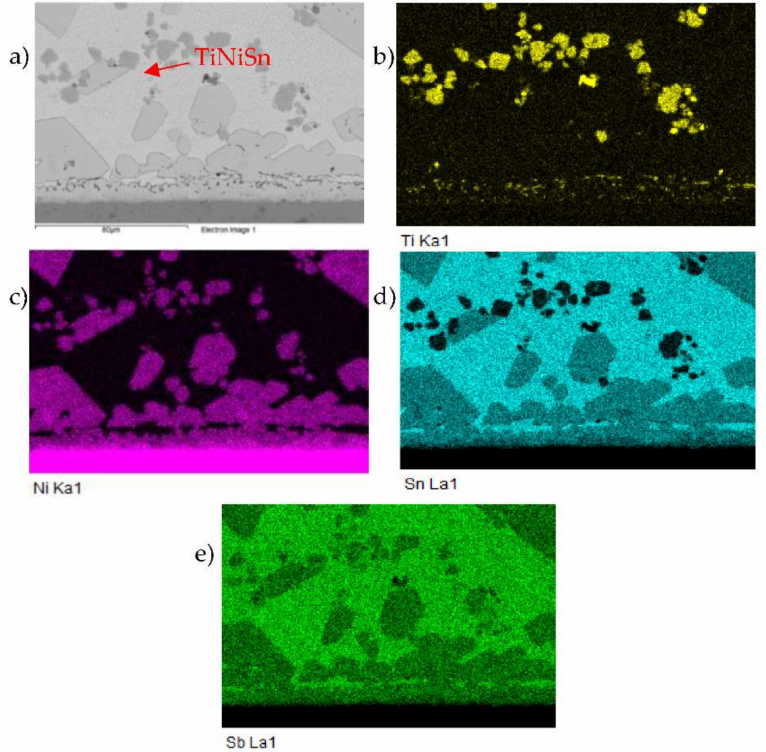
Figure 17. Map of elements in the boundary of Ni/Sn5Sb3Ti joint; ( a ) joint boundary; ( b ) Ti; ( c ) Ni; ( d ) Sn; ( e )